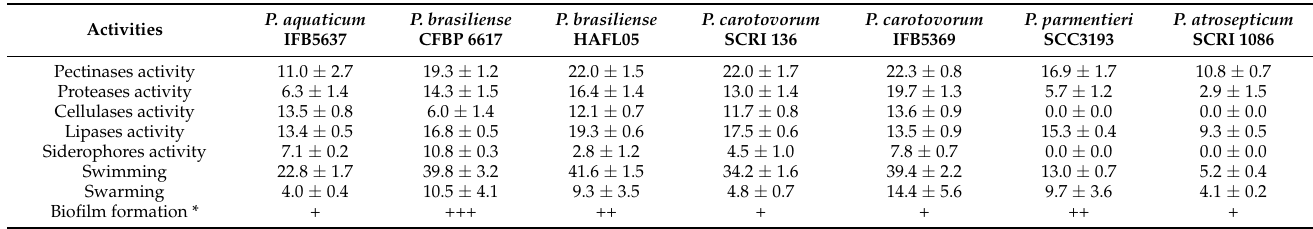
Table 2. Phenotypic characteristics of P. aquaticum IFB5637 strain isolated in Poland in comparison to the tested Pectobacteri- aceae